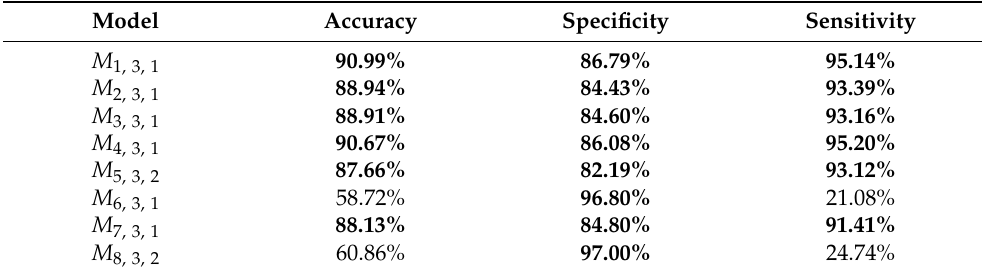
Table 7. Metrics for Patient